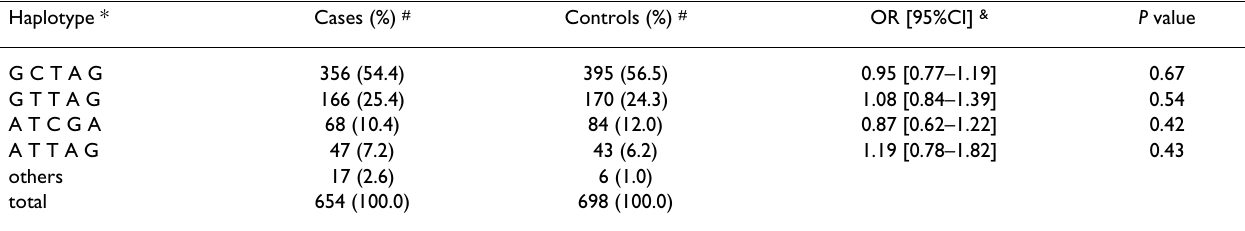
OR = Odds ratio, CI = Confidence interval *Composed of five SNPs: rs7579646, rs840088, rs3795877, rs6749096, and rs3795879; # Data are presented as number of chromosome (%); & OR value just for the major haplotypes (haplotype frequency >